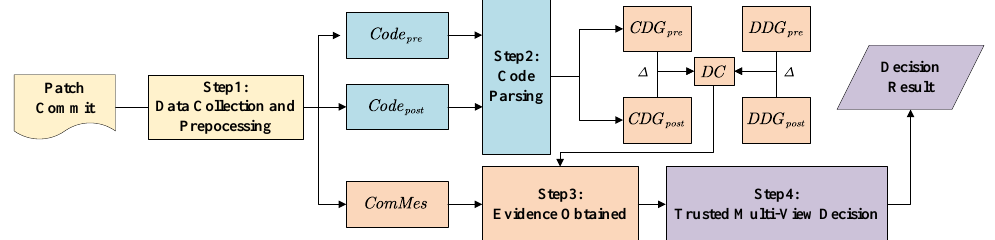
Figure 1. The overall architecture of